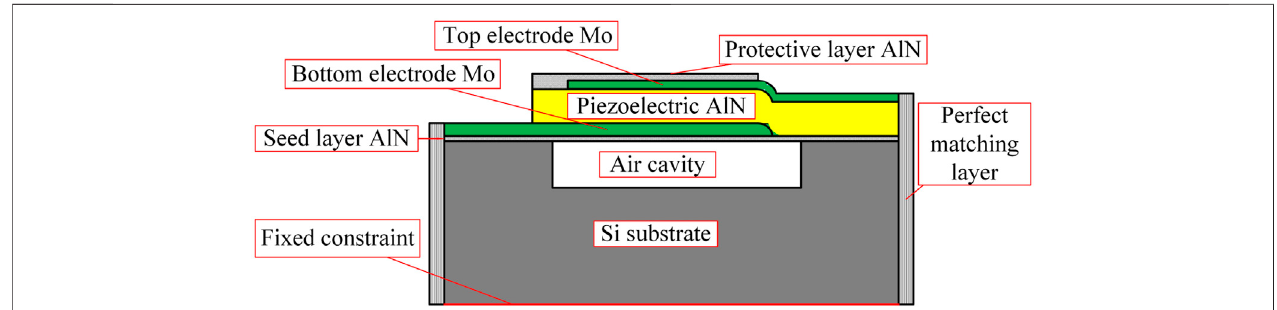
FIGURE 1 | 2D model of the